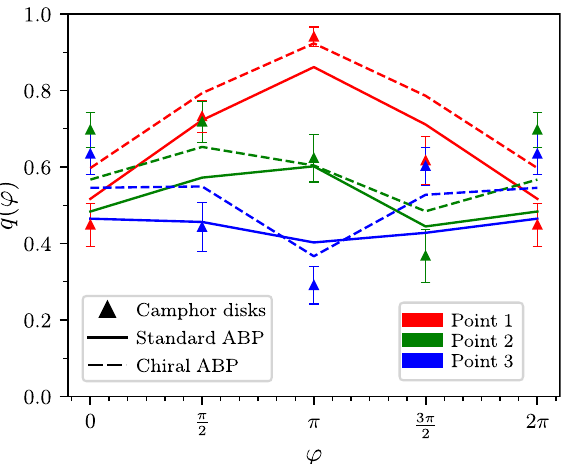
Figure 4. Committor q as a function of the exitangle ϕ for the three different initial conditions. Mean and standard errors of camphor-disk experiments are given by the symbols and the associated vertical bars respectively. Solid lines represent the results of the plain ABP (with a persistence length ℓ = 0.2 , see “Materials and methods” section) and dashed line are the results of the chiral